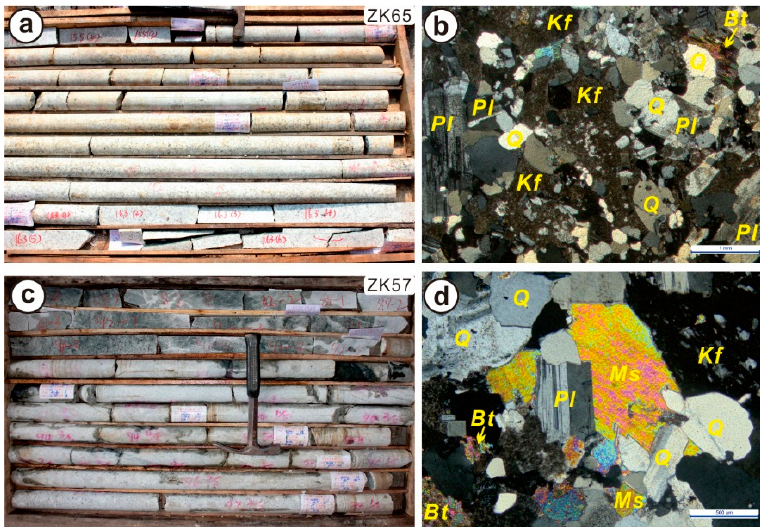
Figure 3. Drill cores and micrographics of ZK65 and ZK57 from the Xinfeng mine, Xianghualing area, South China. ( a , b ) Biotite monzonitic granites from ZK65. ( c , d ) Two-mica monzonitic granite from ZK57. Q, quartz; Kf, feldspar; Bt, biotite; Ms, muscovite; Pl, plagioclase.